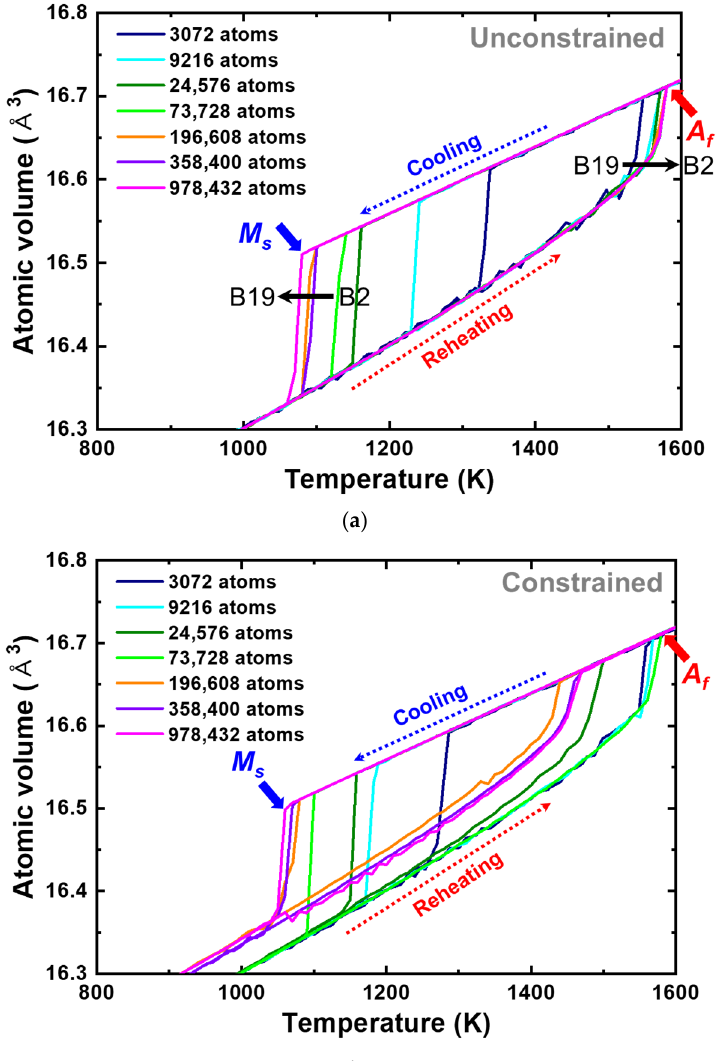
Figure 6. Atomic volume vs. temperature plots of single crystalline equiatomic PtTi with ( a ) unconstrained and ( b ) constrained conditions predicted using the present interatomic potential. The number of atoms of individual cell configurations is provided in legends. The cooling and reheating curves are indicated using dotted lines. The onset of the abrupt change in the atomic volume during cooling (occurring due to an austenite to martensite phase transformation) is marked by the martensite start temperature ( M s ), and the offset of the abrupt change in atomic volume during reheating (occurring due to martensite to austenite phase transformation) is marked by the austenite finish temperature ( A f